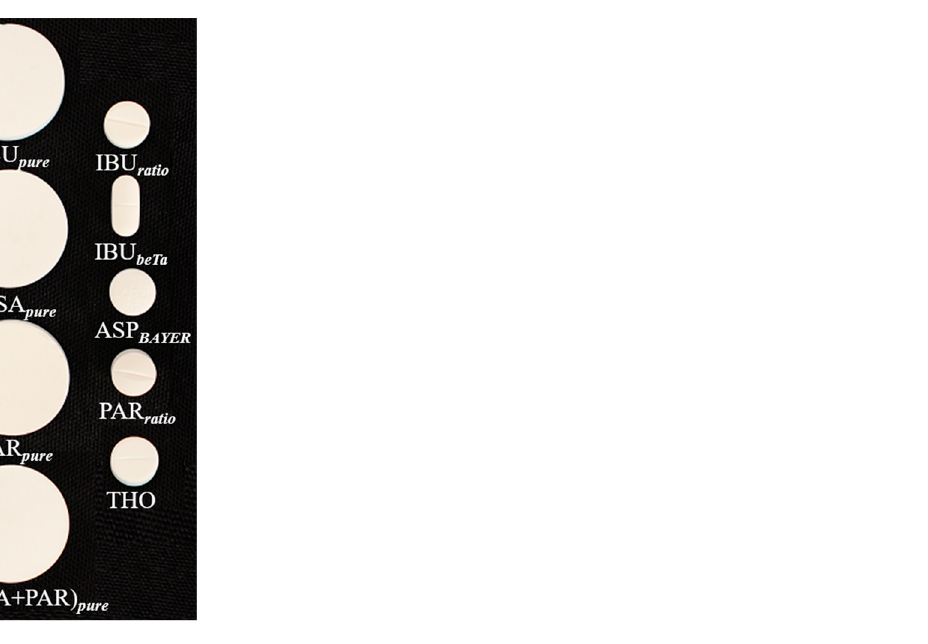
Figure 1. Drug samples. Left column: Reference API samples, right column: painkiller tablets. Table 1. Types of drug samples.